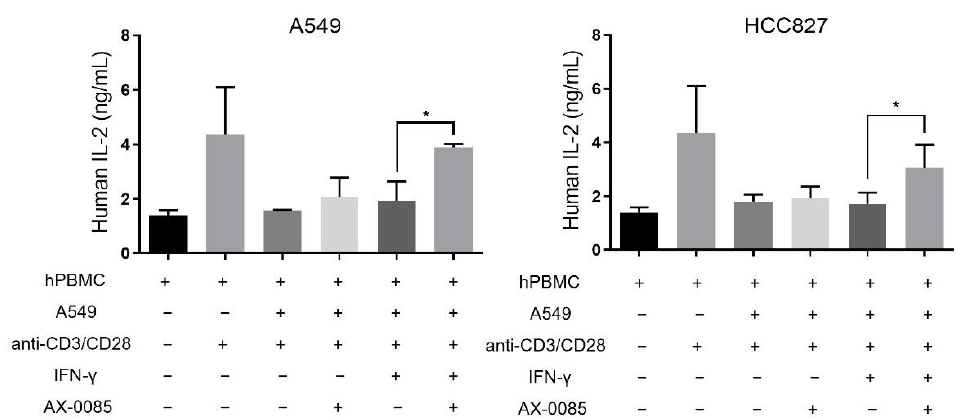
Figure 5. AX-0085 reverses IFN- γ -induced inhibition of T cell activation. Graphs show the results from ELISA assays for secreted IL-2 from PBMC. Treatment with anti-CD3/CD28 antibodies activates IL-2 secretion from PBMC. LUAD cells sequentially treated with IFN- γ and AX-0085 were mixed with activated PBMC, and IL-2 secretion was measured (see Materials and methods section). Reversion of inhibition of IL-2 secretion by LUAD cells or IFN- γ by AX-0085 is shown to be statistically significant. Data are mean ± SEM of three independent experiments (* p -value of <0.05 from Student’s t -test).